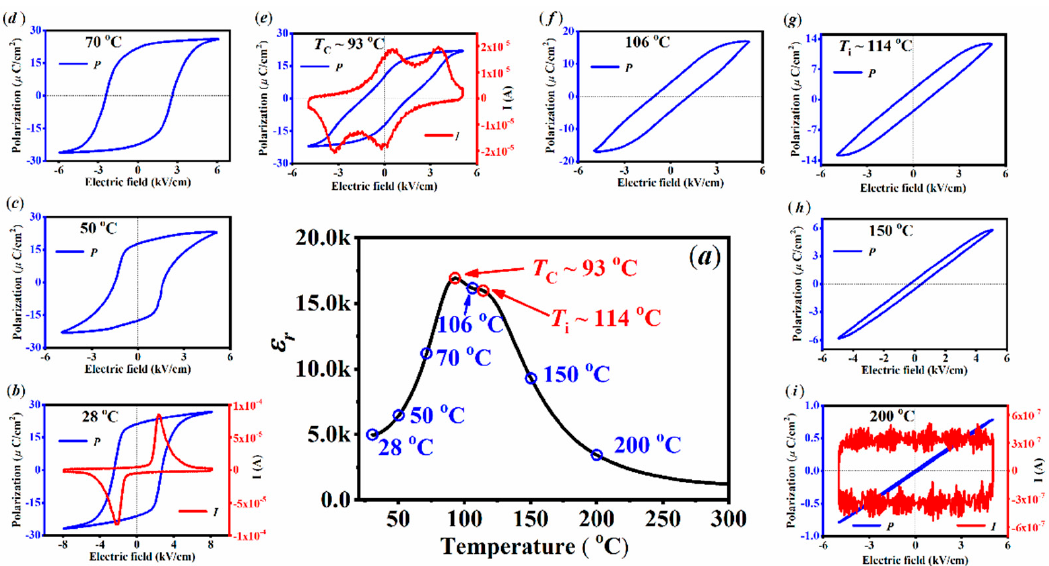
Figure 4. ( a ) The temperature dependence of dielectric constant ε r for 2.19%Nd-PMNT31 single crystals (1 Hz); ( b – i ) the P - E hysteresis loops and I - E curves of 2.19%Nd-PMNT31 single crystals at different temperature.